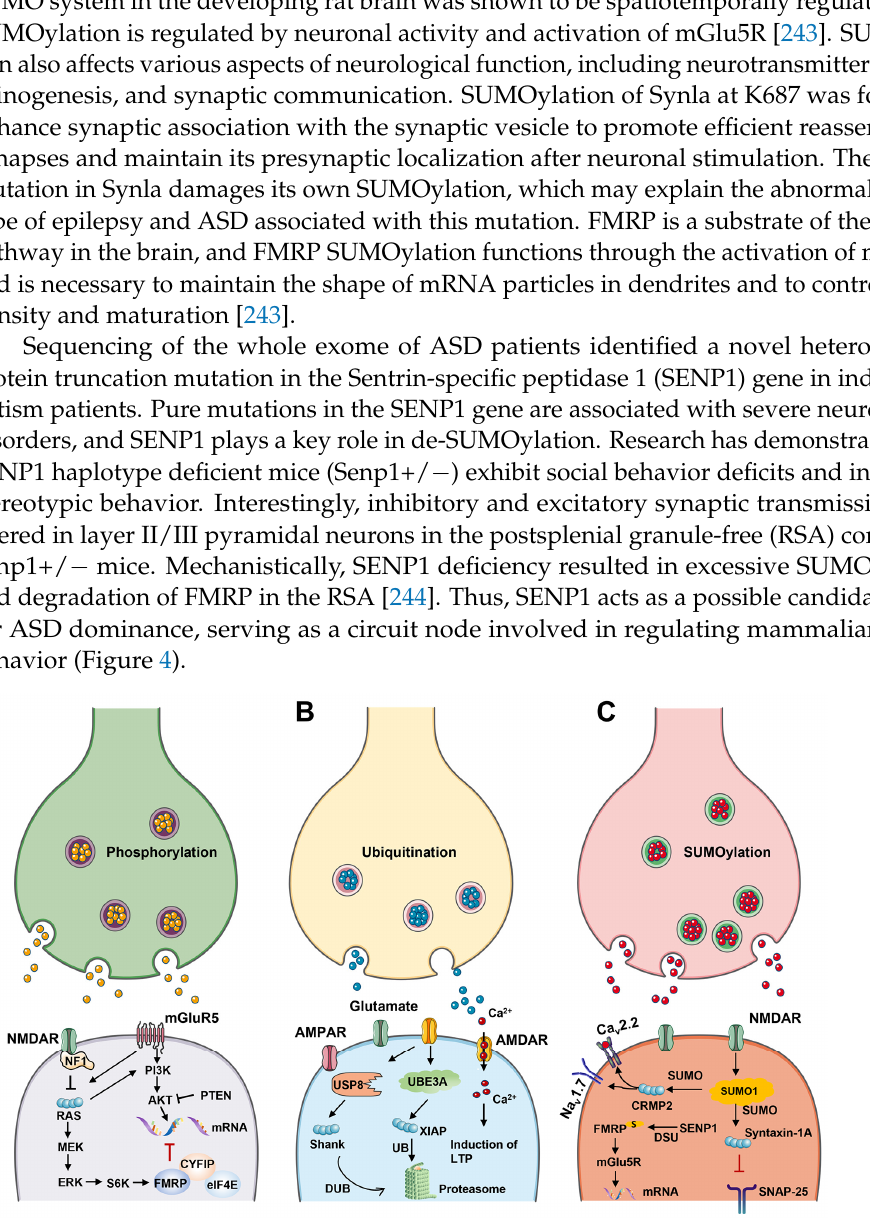
Figure 4. A network of epigenetic post-translational modifications associated with ASD patho- physiology. ( A ) Ras inactivation is generally caused by neurofibrillar proteins encoded by NF1. Neuro- fibrillary protein mutations in neurofibromatosis 1 cause excessive activation of the Ras/ERK and PI3K signaling pathways, affecting and inhibiting translation of proteins encoded by genes associ- ated with neurodegenerative diseases in autism. ( B ) USP8 is required for synaptic function by sta- bilizing Shank family proteins to prevent degradation. UBE3A regulates synaptic activity by target- ing XIAP ubiquitination. ( C ) FMRP activity-dependent SUMOylation is a critical step in the separa- tion of FMRP from dendritic mRNA particles, which regulates spine elimination and maturation. CRMP2 is a SUMO substrate that reduces Ca2 + entry via the presynaptic voltage-gated Ca2 + channel CaV2 in a dynamic manner. 2. CRMP2 SUMOylation is also thought to regulate membrane expres- sion in the sodium channel NaV1.7. Syntaxin-1A SUMOylation is induced by NMDAR activation, resulting in decreased binding to SNAP-25 and serving as a key presynaptic modulator of vesicular endocytosis. 4.5. Immunology and Neuroinflammation